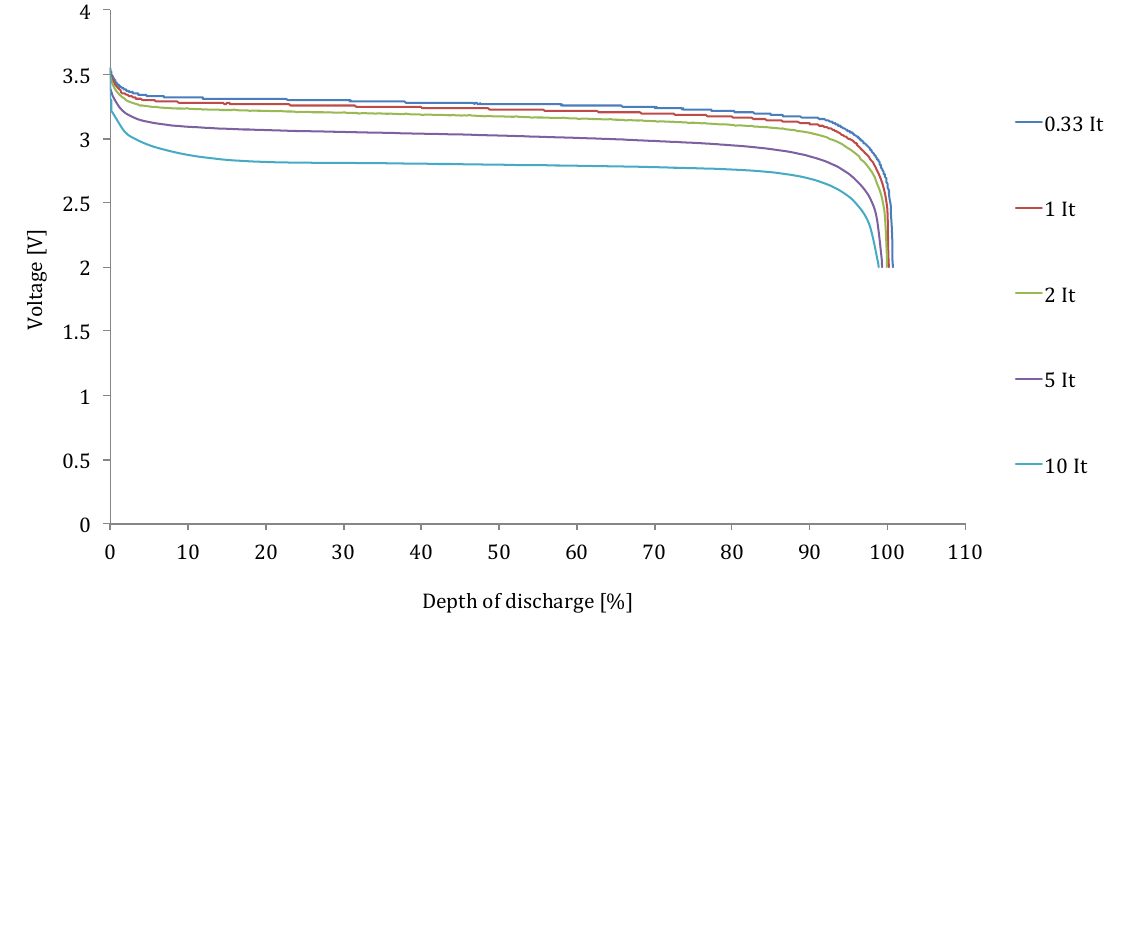
Figure 11. Discharge behaviour of battery brand A-LFP (high